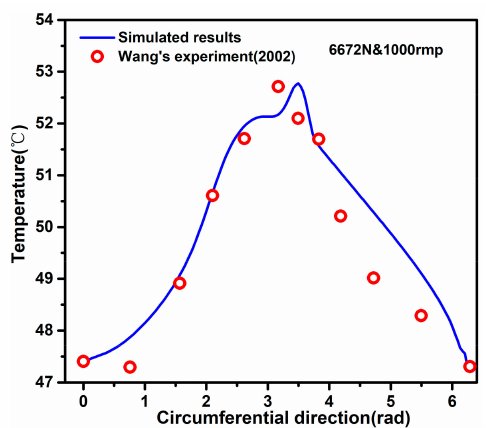
Figure 7. Temperature analysis results in comparison with the experiment data from Wang et al. [19] under different working conditions (6672 N and 1000